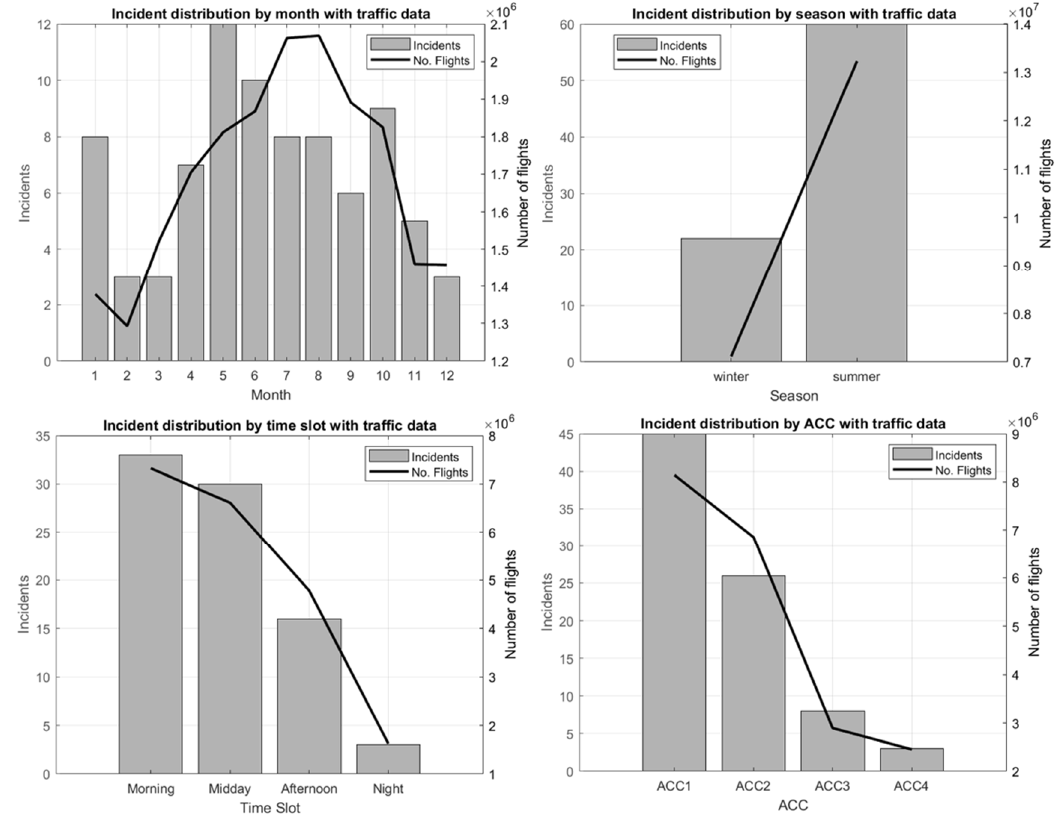
Figure 6 . Distribution of incidents by month, season, time slot and